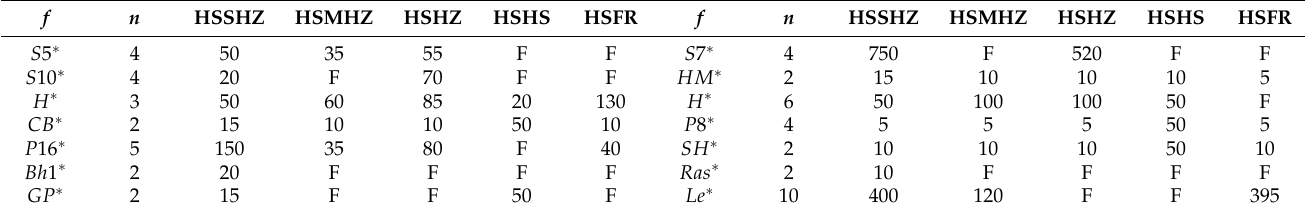
Table 11. The number of best